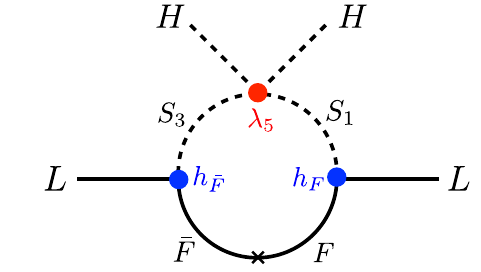
Fig. 1 The one-loop diagram generating the neutrino masses